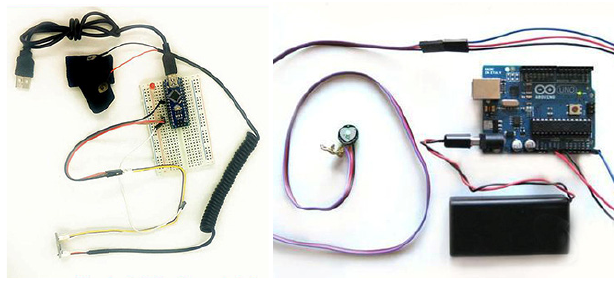
Figure 8. GSR skin electrical kit ( left ) and pulse sensor ( right ).